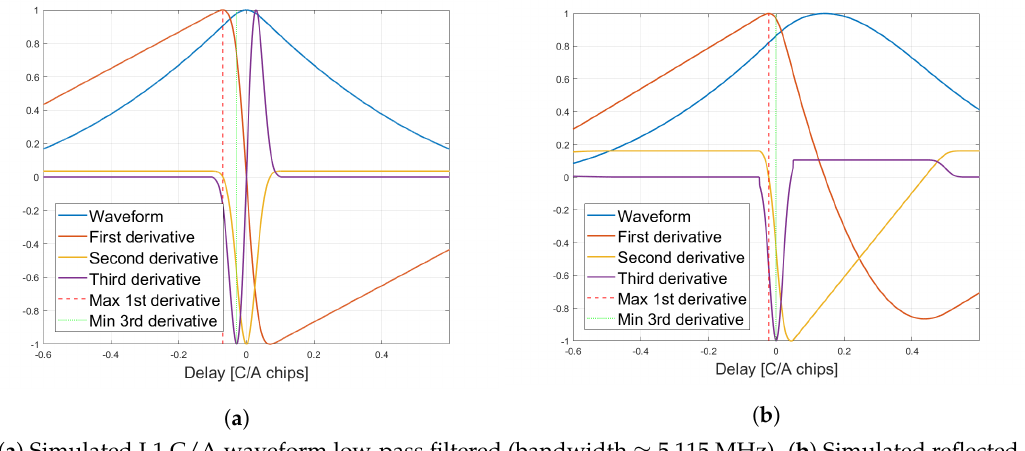
Figure 7. ( a ) Simulated L1 C/A waveform low-pass filtered (bandwidth ≈ 5.115 MHz). ( b ) Simulated reflected L1 C/A waveform low-pass filtered (convolution of Figure 7a and Figure 6b). The maximum of the first derivative shifts towards the negative delays, while the minimum of the third derivative remains closer to the zero